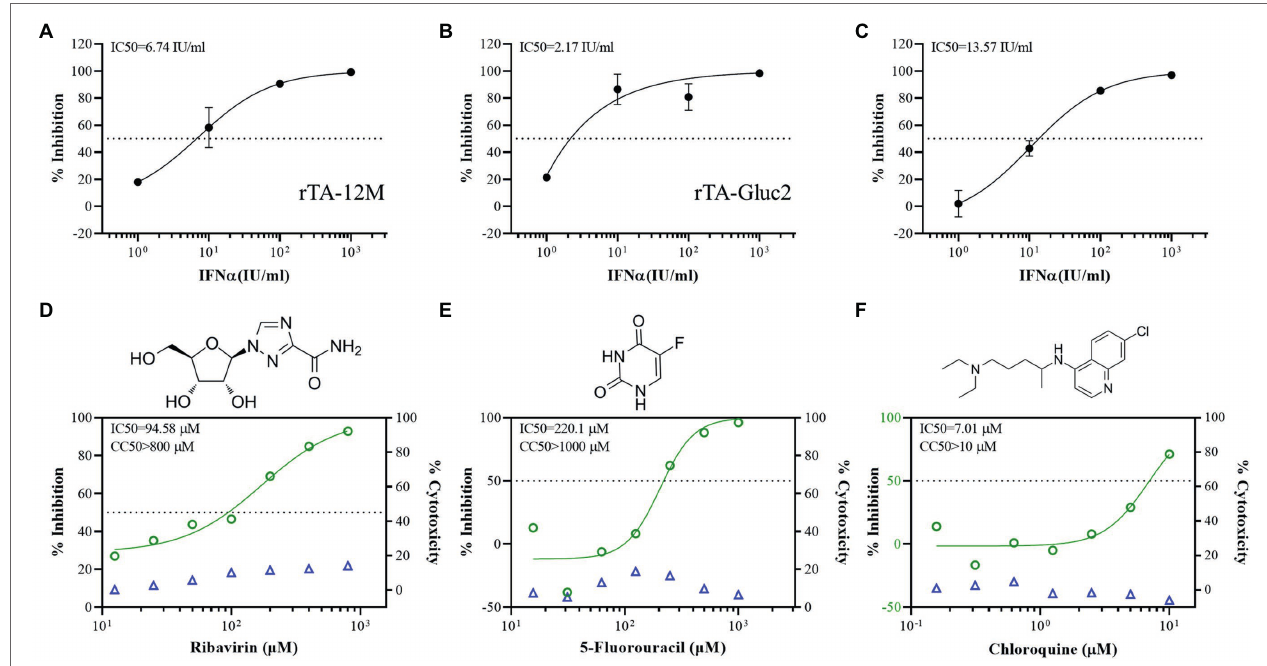
FIGURE 4 | The antiviral assay using the Gluc reporter virus. (A,B) The inhibitory effect of IFN- α on the infection of rTA-12 M and rTA-Gluc2 based on virus titer (TCID 50 ). (C) The inhibitory effect of IFN- α on the infection of rTA-Gluc2 based on gaussia luciferase activity. (D–F) The inhibitory effect of the compounds on the infection of rTA-Gluc2 based on gaussia luciferase activity. The inhibition rate is the reduction percentage of viral replication compared to the no treatment control. Each data point represents the mean ± deviation of